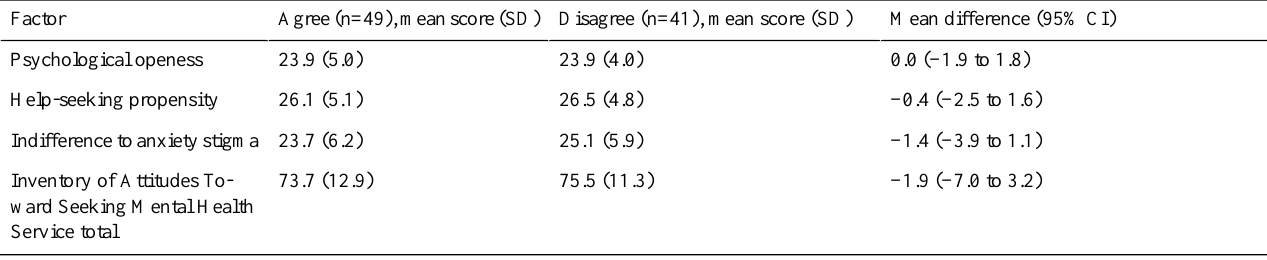
Table 2. Inventory of Attitudes Toward Seeking Mental Health Services factor scores by agreement with using text messaging to communicate with a professional to receive help for managing anxiety.